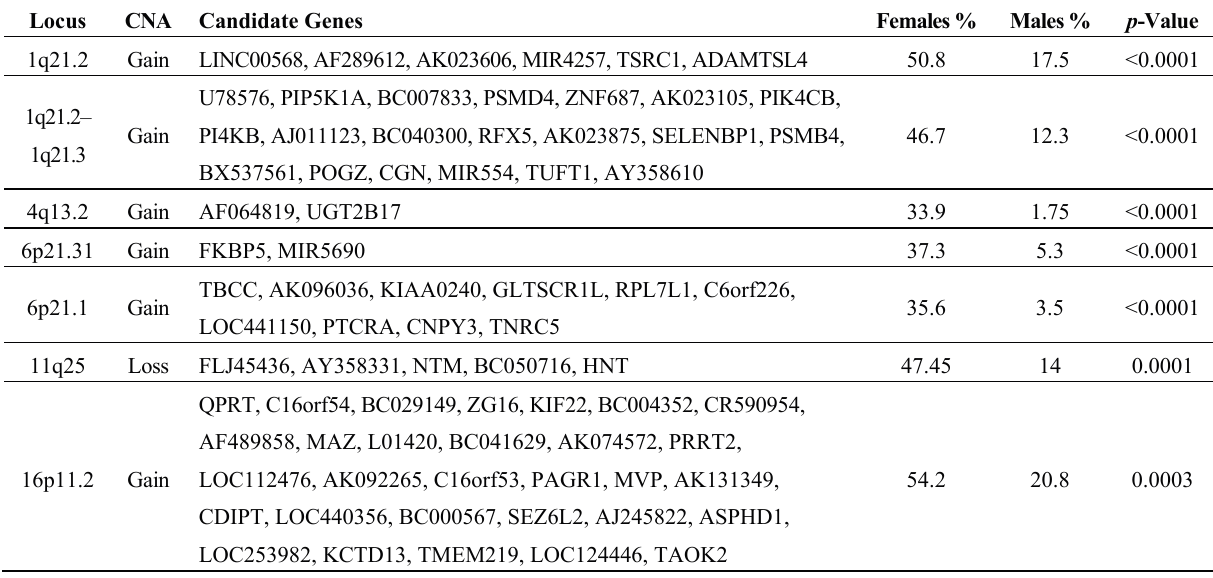
Table 2. Gender-specific copy number aberrations and associated genes in colorectal